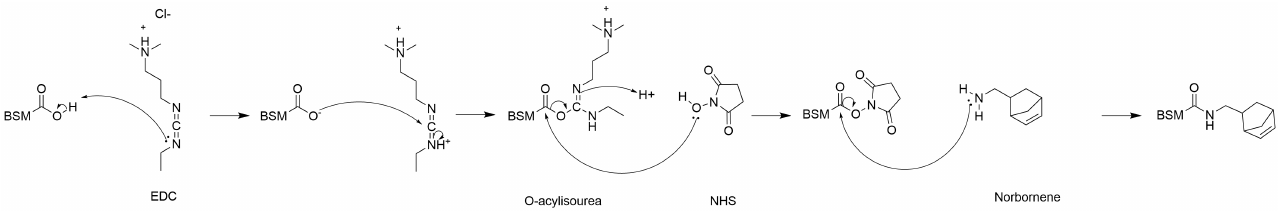
Figure A2. EDC NHS coupling